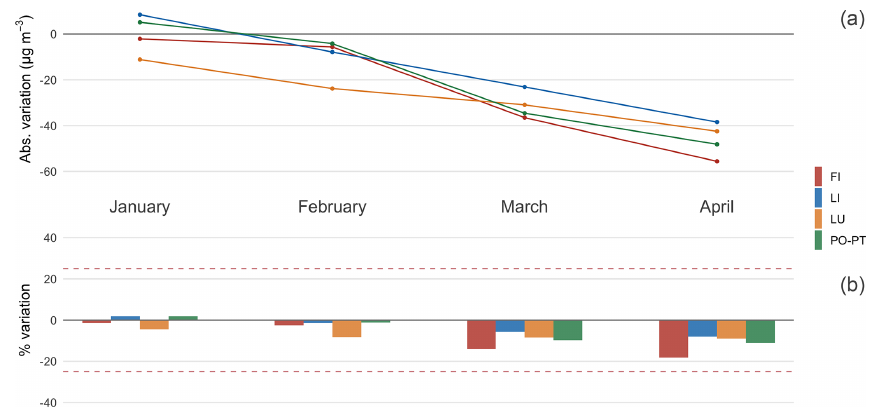
Figure 6. NO 2 (a) absolute variation and (b) percentage variation between monthly means of 2020 and 2017–2019 in the four considered areas.